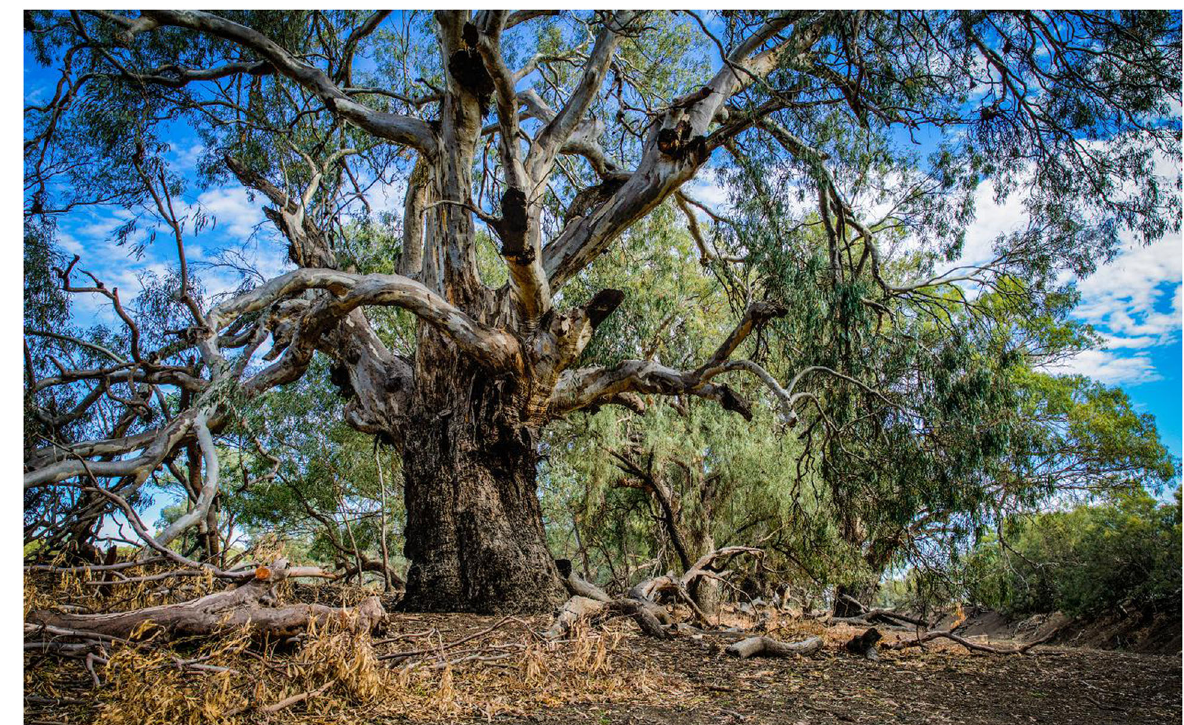
Fig. 1 A large old tree (river red gum, Eucalyptus camaldulensis ) and its habitat features. Top: canopy branches, deadwood, leaves, seeds and flowers. Middle: broken branches, hollows, rough bark and trunk fissures. Bottom: fallen leaves, bark, and branches (Source: Chris